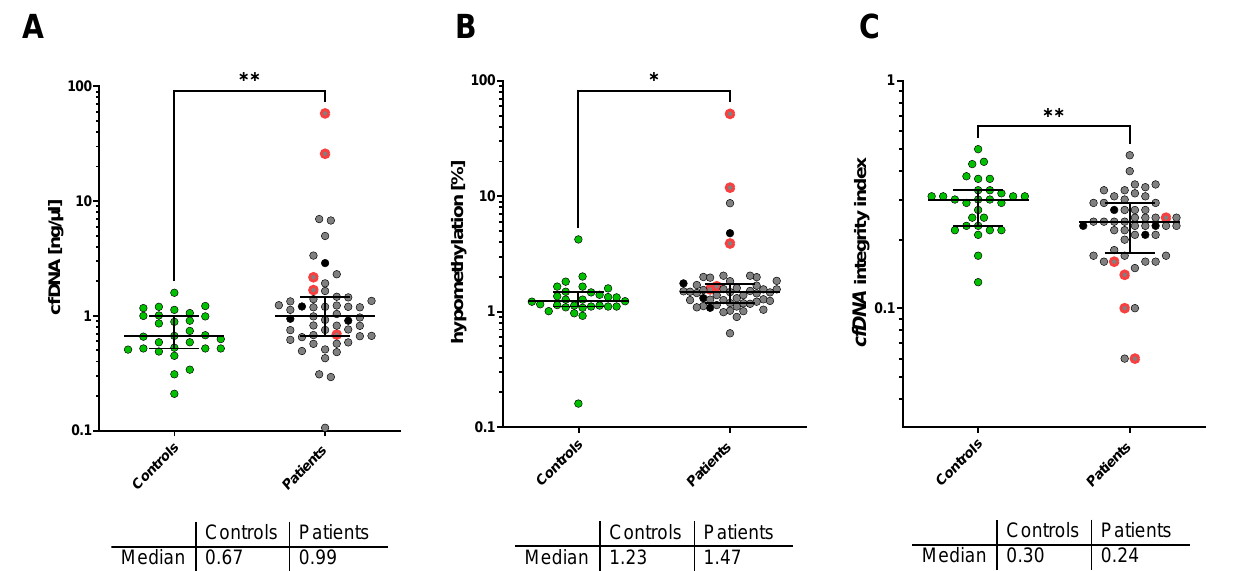
Figure 1. Plasma cfDNA concentration ( A ), cfDNA Alu hypomethylation ( B ), and LINE-1 cfDNA integrity ( C ) in the healthy control group (green) and patients with metastatic NEN (grey). Deceased patients are marked in red, patients lost to follow-up in black. * p < 0.05; ** p < 0.005 in the Mann–Whitney U-test.